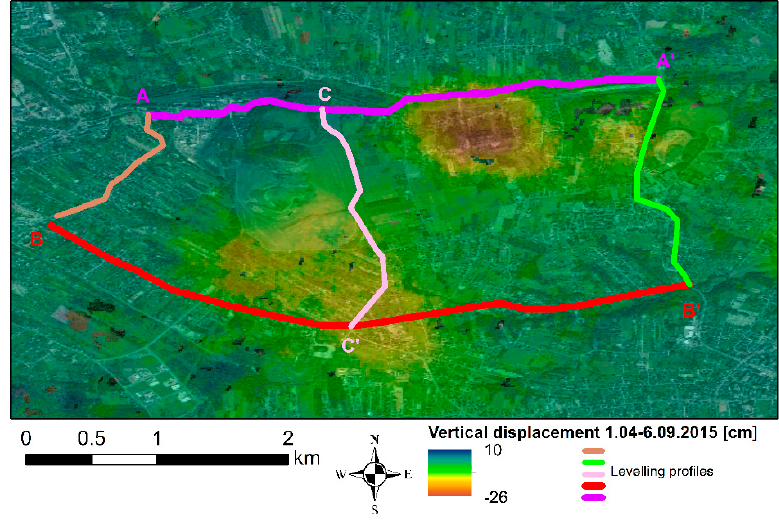
Figure 14. DInSAR-based vertical displacement verification with leveling data.